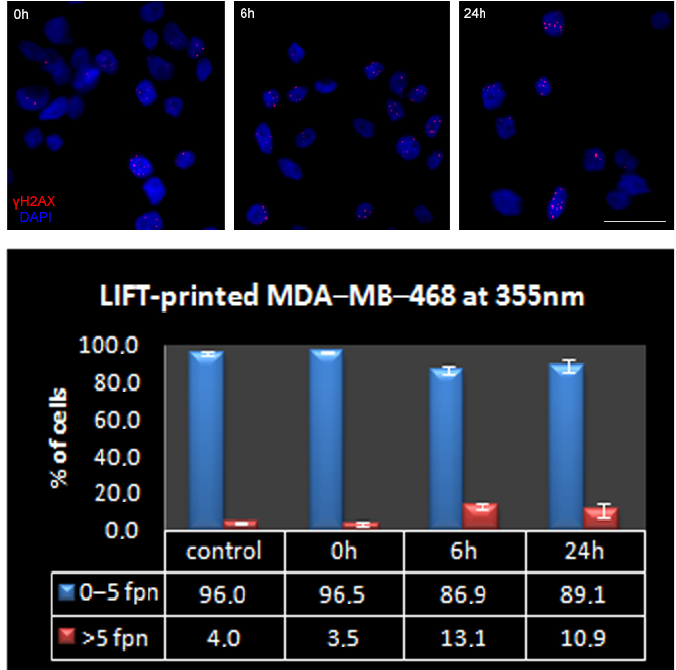
Figure 10. ( Top ) Representative IF images of γ H2AX foci of control or printed MDA-MB-468 cells at 355 nm. Cell nuclei were counterstained with DAPI, scale bar = 20 μ m. ( Bottom ) The percentage of high- and low-DSB-bearing populations at control or given timepoints after LIFT-printing of MDA-MB-468 at 355 nm, fpn-foci per nucleus. The measurements were obtained from at least 3 independent experiments and the total cells analyzed were: control = 1221, 0 h = 521, 6 h = 1177, 24 h = 1084.